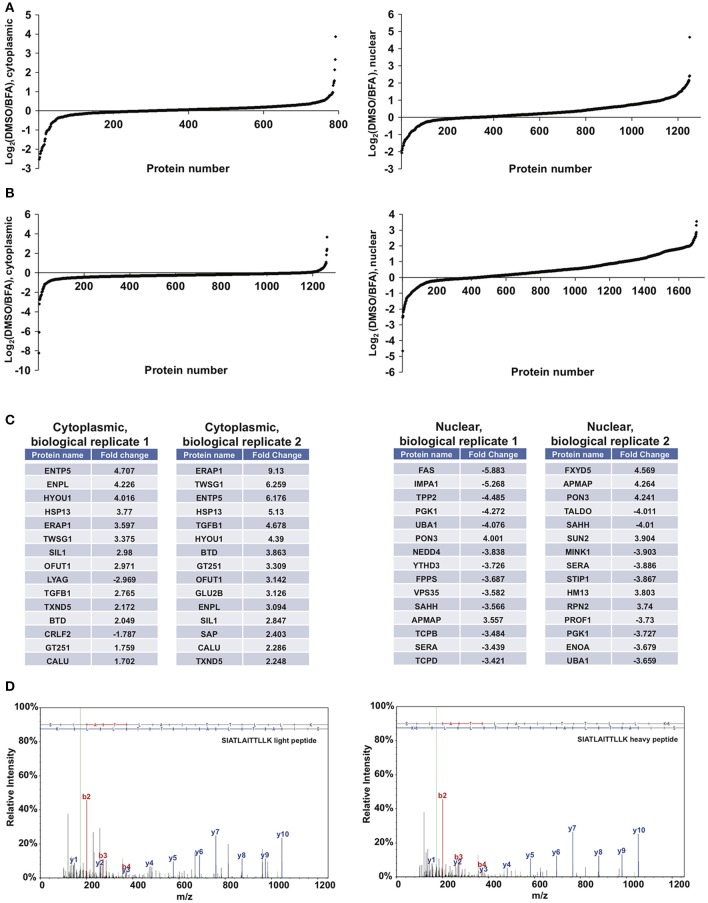
Glycoproteomics workflow detects global BFA-induced changes in O-GlcNAcylated proteins. Data for nuclear and cytoplasmic proteins are displayed as a log2 transform of the ratio of detected intensities from the DMSO and BFA samples, as described previously (66–68). (A) In the first biological replicate, 1,252 nuclear and 792 cytoplasmic proteins were identified. (B) In the second biological replicate, 1,703 nuclear and 1,262 cytoplasmic proteins were identified. (C) The nuclear and cytoplasmic proteins exhibiting concordant BFA-dependent changes (up or down) across biological replicates were rank-ordered by the magnitude of the fold-change between DMSO and BFA samples, as described previously (66–68). Tables list the top 15 nuclear and cytoplasmic proteins from each biological replicate by this ranking. Some proteins appear in both tables but at different positions, reflecting rank-order in each case. (D) Representative MS spectra from one SILAC biological replicate, depicting light and heavy versions of the COPγ1 peptide SIATLAITTLLK. Complete proteomics datasets are available as Supplemental Material.